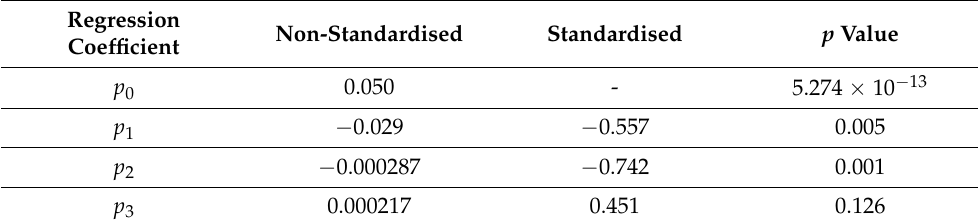
Table 6. Regression coefficients and p values for moderator